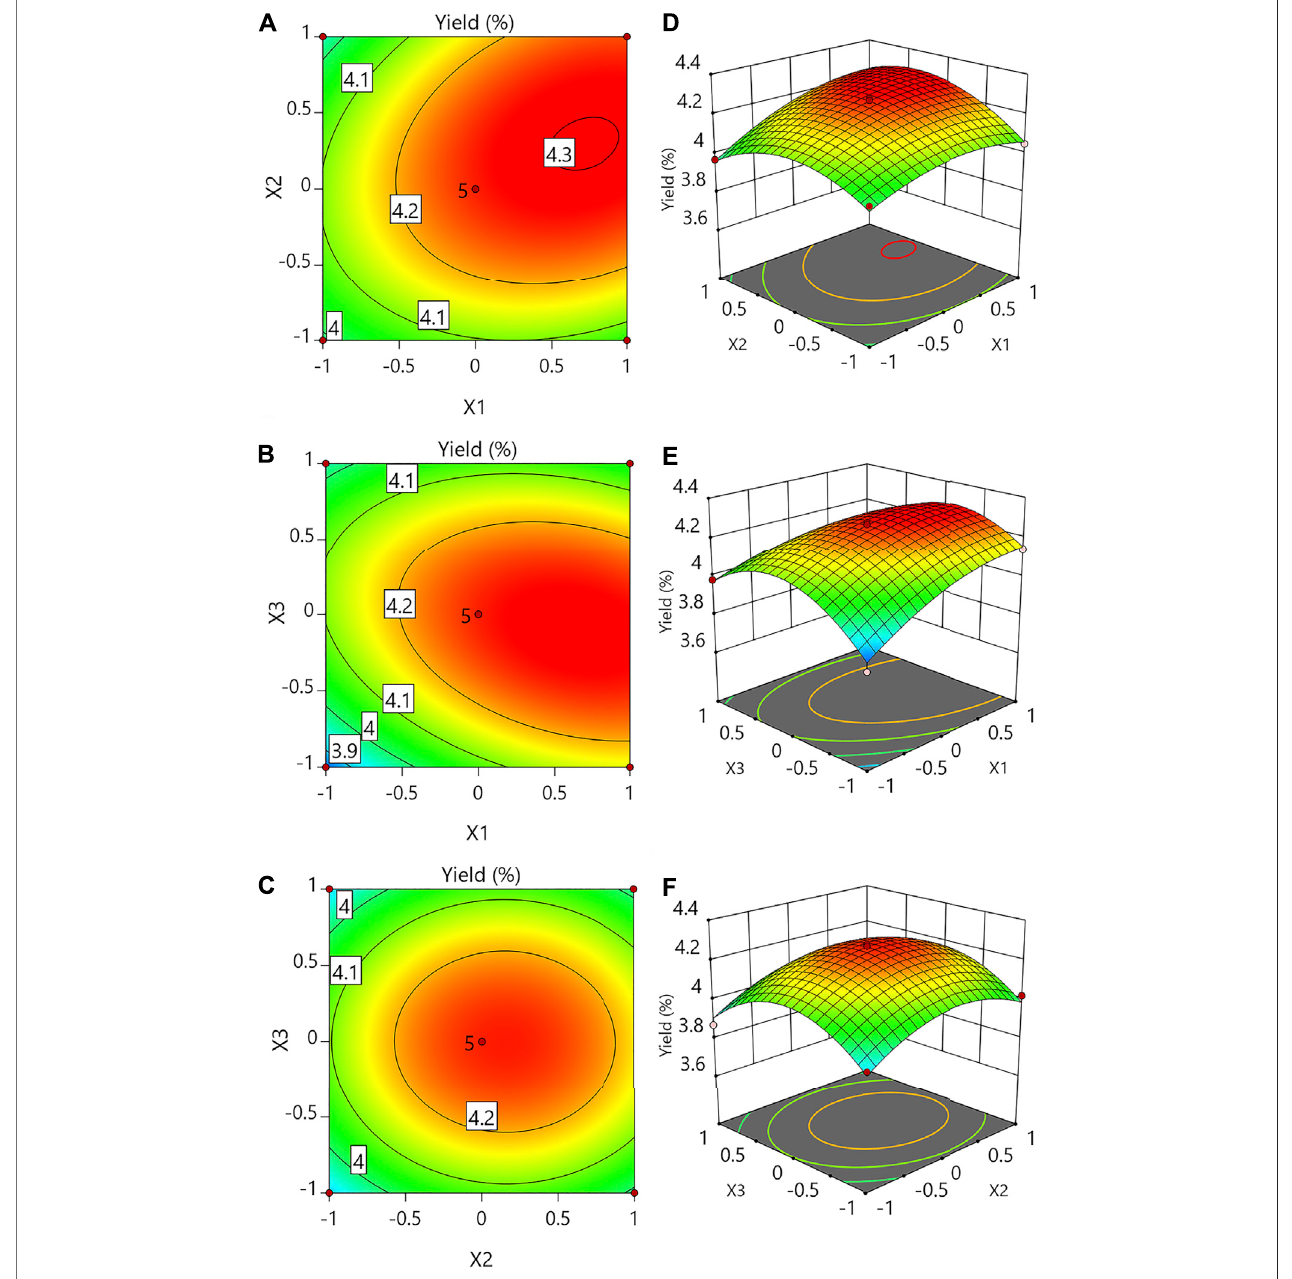
FIGURE1| Contourplots (A – C) andresponsesurfaceplots (D – F) showingtheeffectsofvariables( X 1 :temperature; X 2 :liquid-to-solidratio; X 3 :perextractiontime) on the response Y (yield of CSP).